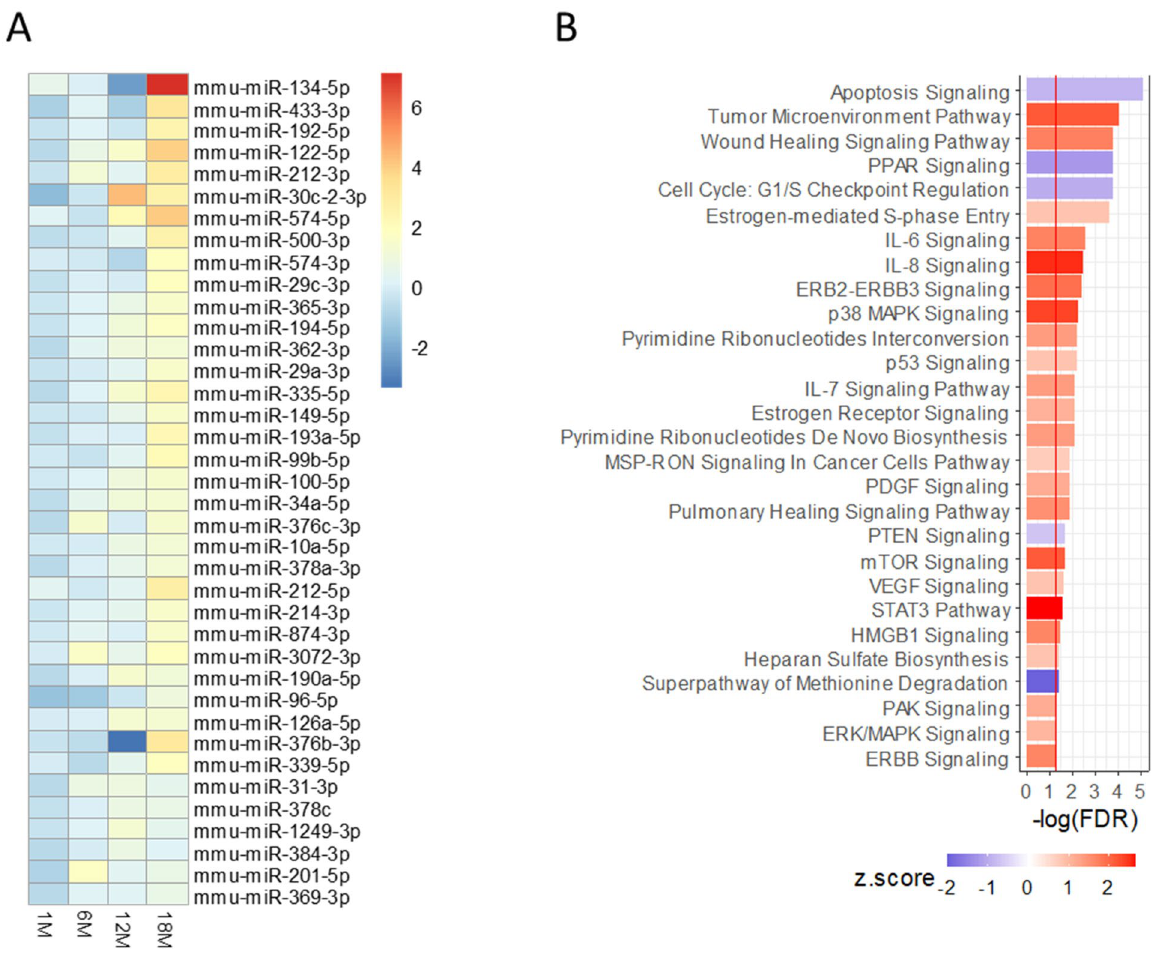
Figure 3. Validation of hub miRNAs in serially collected plasma samples from irradiated F2 mice diagnosed with HCC. ( A ) Normalized plasma levels of 38 circulating hub miRNA validated in F2 mice. ( B ) Signaling pathways of the predicated gene targets of the 38 validated circulating miRNA markers. The horizontal axis represents enrichment scores. The colors of the bars represent the z-scores of the pathways, red: activation; blue: suppression. The red line represents the cutoff of enrichment (FDR <